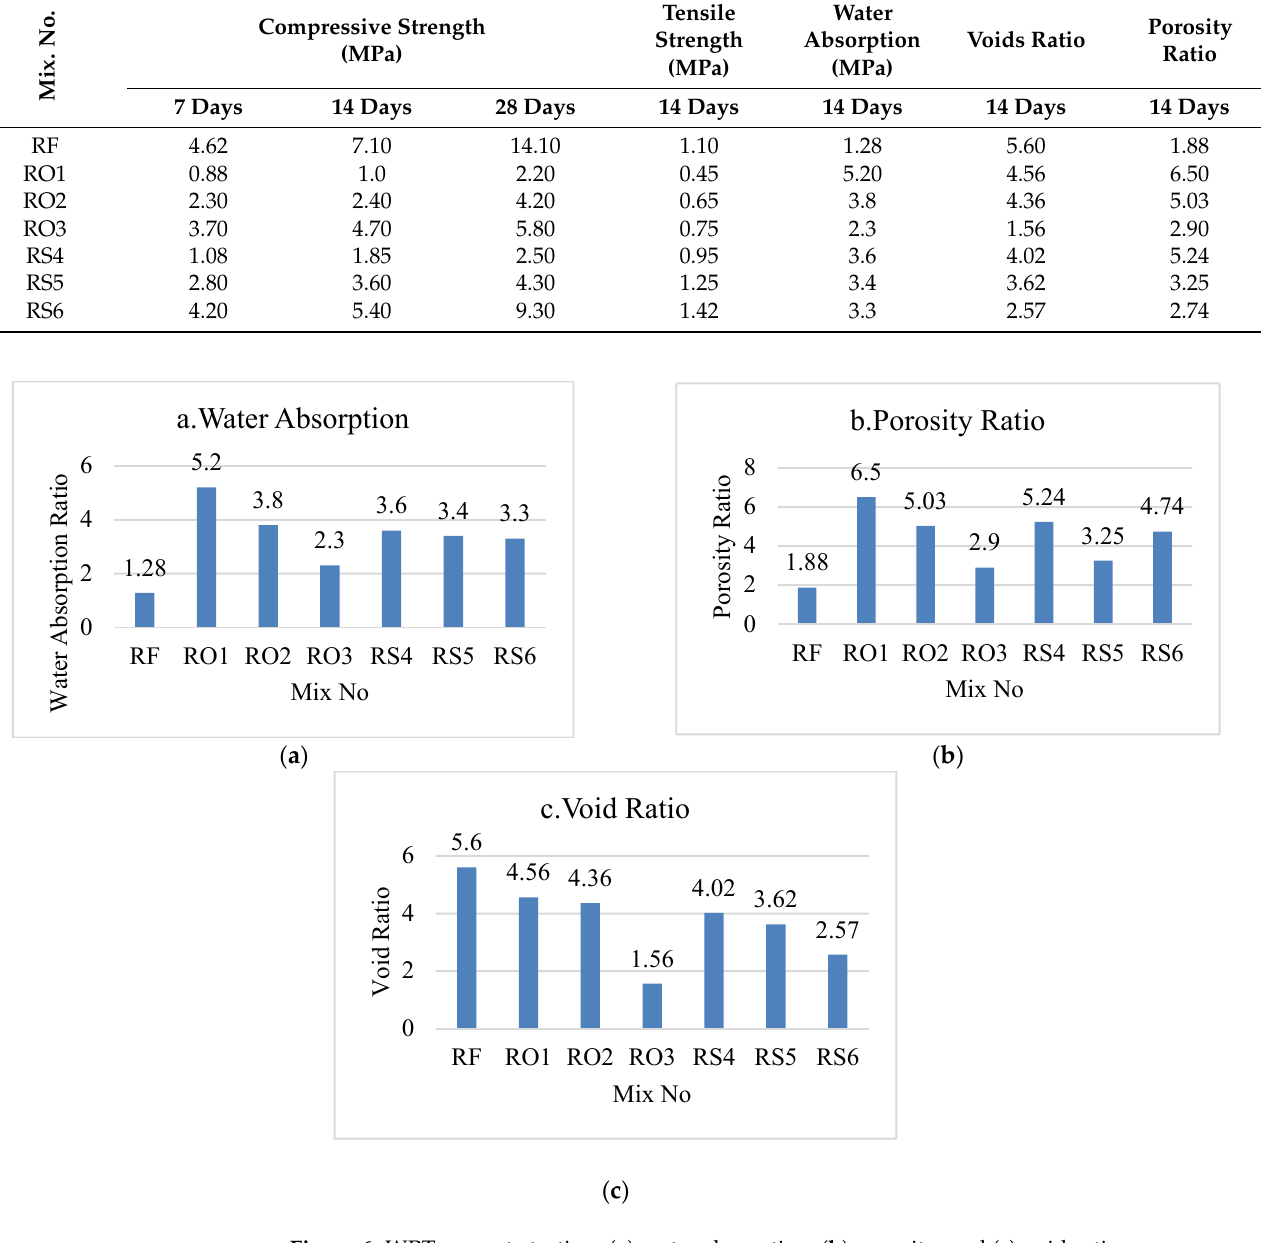
Figure 6. WRT concrete testing: ( a ) water absorption; ( b ) porosity; and ( c ) void ratio. Table 7. Mechanical properties of samples after 7, 14, and 28 days.